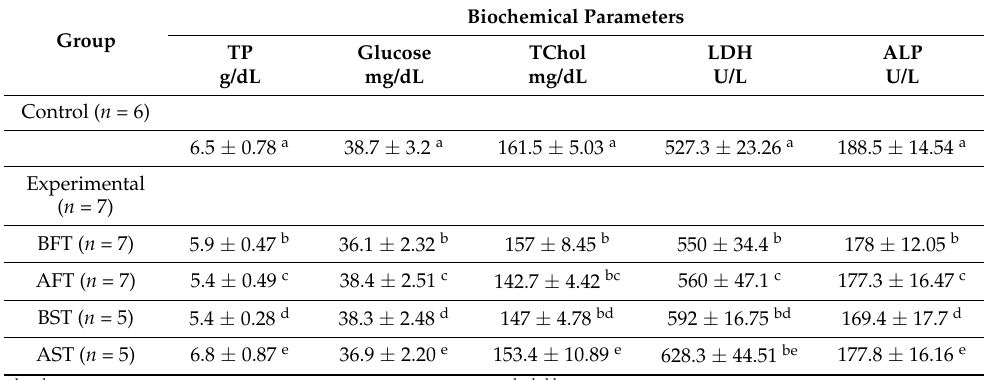
Table 4. Biochemical parameters in the blood serum of control and treated with AyuFertin Bulgarian Murrah